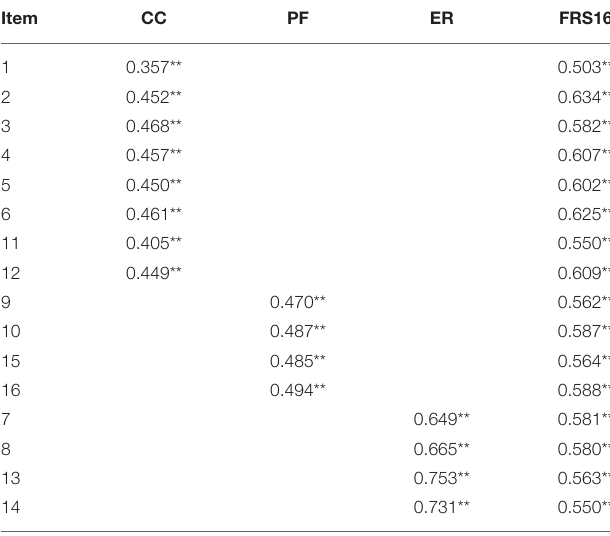
TABLE 4 | Item-to-scale and item-to-subscale correlations. TABLE 5 | Descriptive statistics of demographics (Chinese